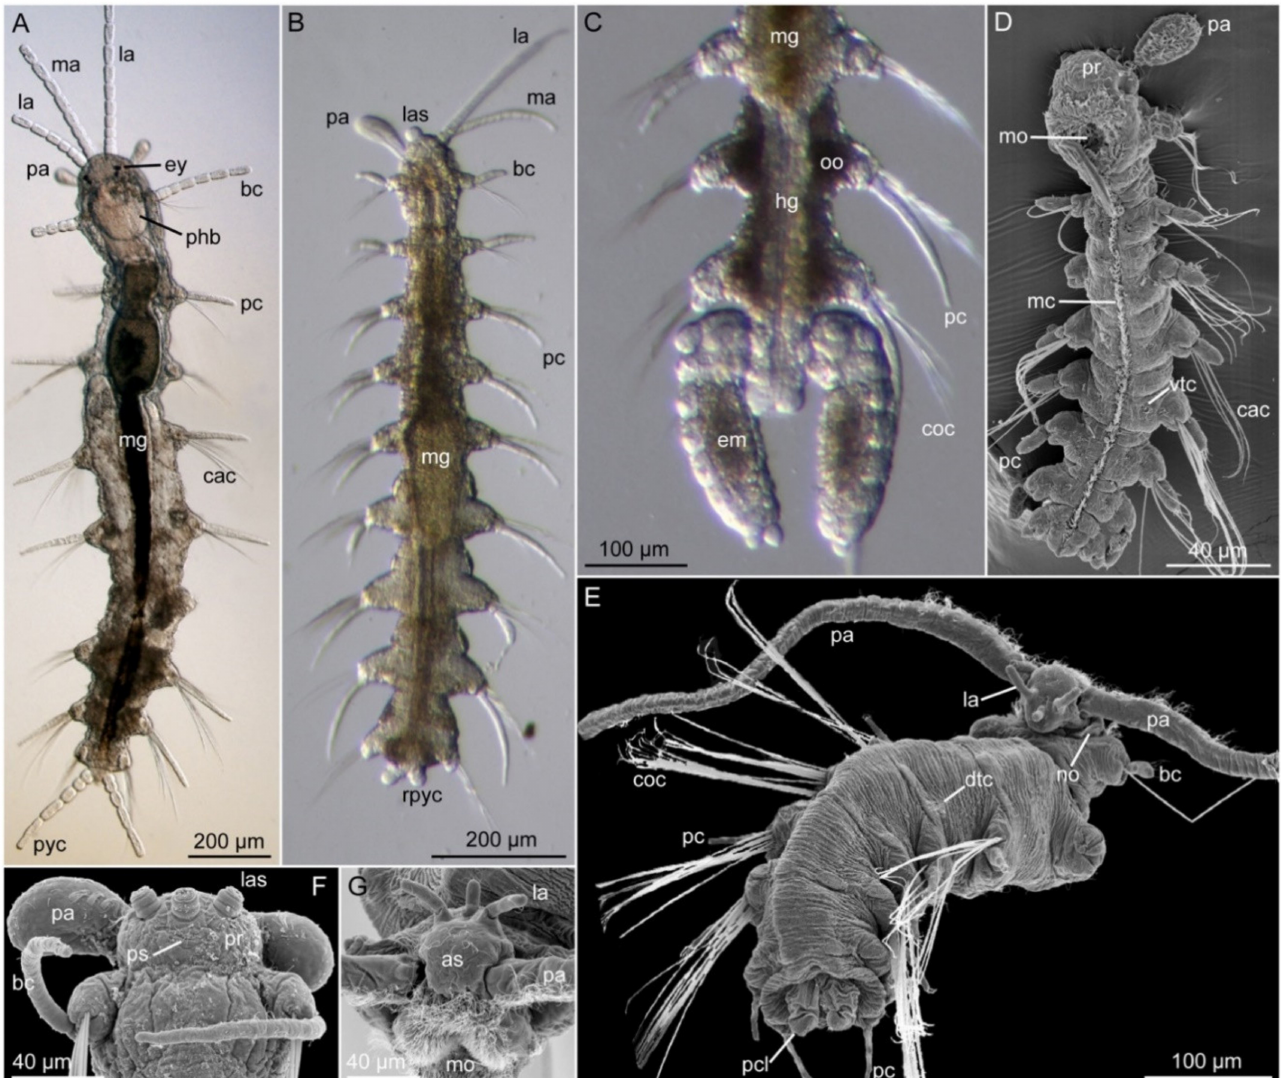
Figure 8. Morphology of Nerillidae (a–c, light micrographs; d–g, scanning electron micrographs). ( A ) Nerilla cf. antennata (from Roscoff, France), dorsal view (modified from [3]). ( B , C ). Mesonerilla cf. luederitzi (from Iriomote Island, Japan), dorsal views; entire male with sperm in posterior segments (b), posterior end of female with oocytes and embryos (c). ( D ). Nerillidium sp. (from Jeju Island, South Korea), ventral view. ( E ). Speleonerilla calypso , dorsal view (modified from [129]). ( F ). Leptonerilla cf. diplocirrata (from Jeju Island, South Korea), anterior end in dorsal view. ( G ) Speleonerilla calypso , anterior end, antero-ventral view. Abbreviations: as, anterior field of sensory cilia; bc, buccal (=segment 1) cirrus; cac, capillary chaetae; coc, compound chaetae; dtc, dorsal tuft of cilia; emb, embryo; ey, eye; hg, hindgut; la, lateral antenna; las, scar from lateral antennae; ma, median antenna; mc, midventral ciliary band; mg, midgut; mo, mouth opening; no, nuchal organ; oo, oocyte; pa, palp; pc, parapodial (interramal) cirrus; pcl, pygidial ciliated lobe; phb, pharyngeal muscular bulb; pr, prostomium; ps, posterior field of sensory cilia; pyc, pygidial cirrus; rpyc, regenerating pygidial cirrus; vtc, ventral tuft of